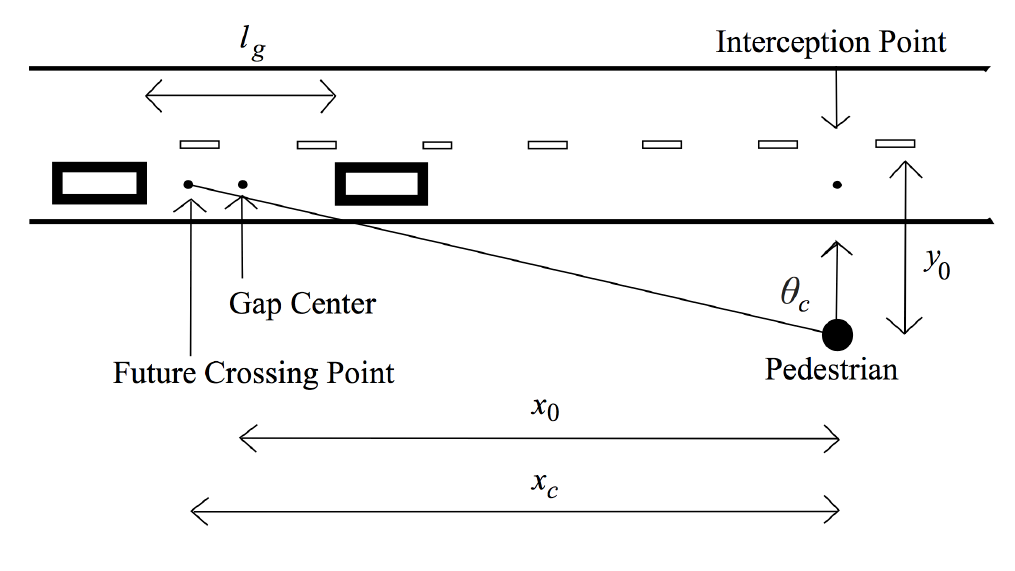
Figure 2. Top-down diagram of the crossing environment at time t = 0. The two boxes on the road depict two vehicles facing the right, which move forward at a constant speed. The circle depicts the pedestrian, who begins at rest and is facing in the direction the arrow. Labeled are experimental parameters l g , y 0 , and the bearing angle to the crossing point θ c